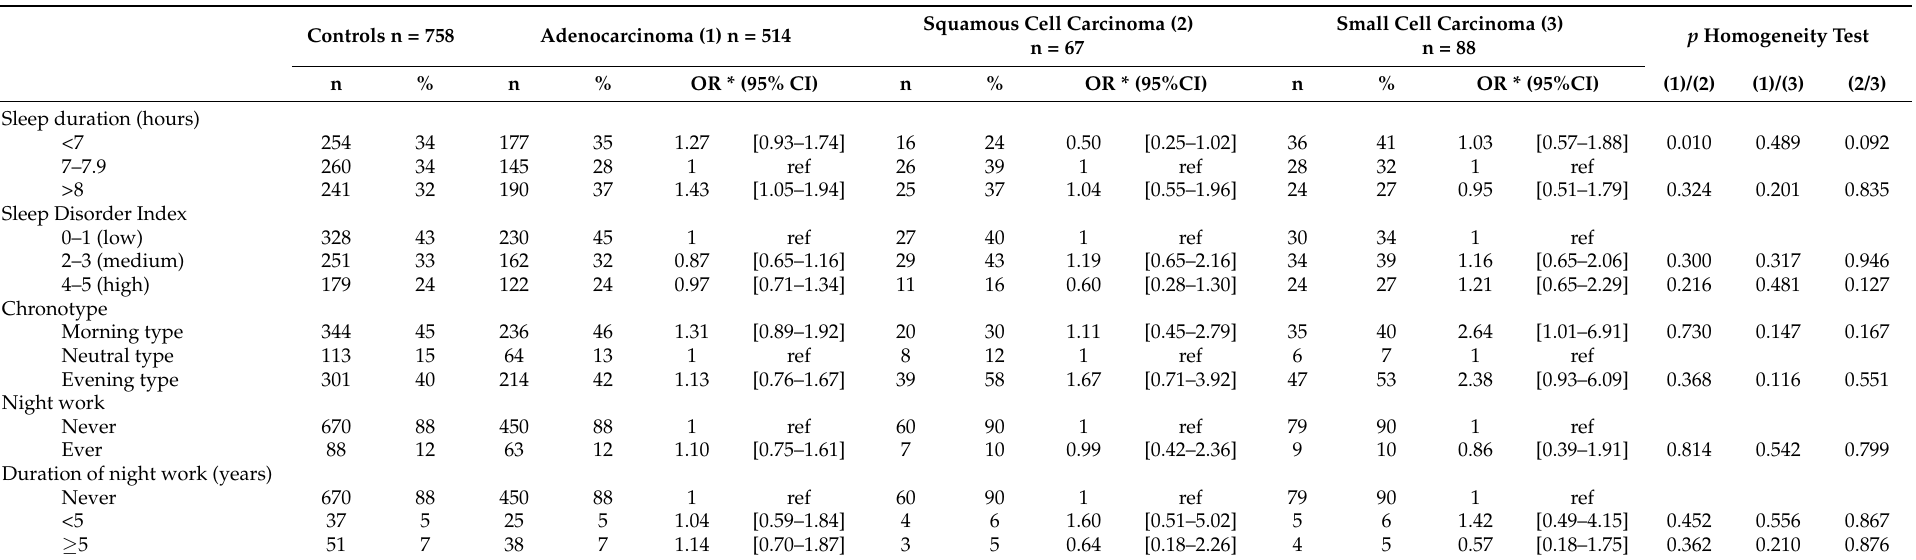
Table 5. Association between sleep traits, chronotype and night work and histological subtypes of lung